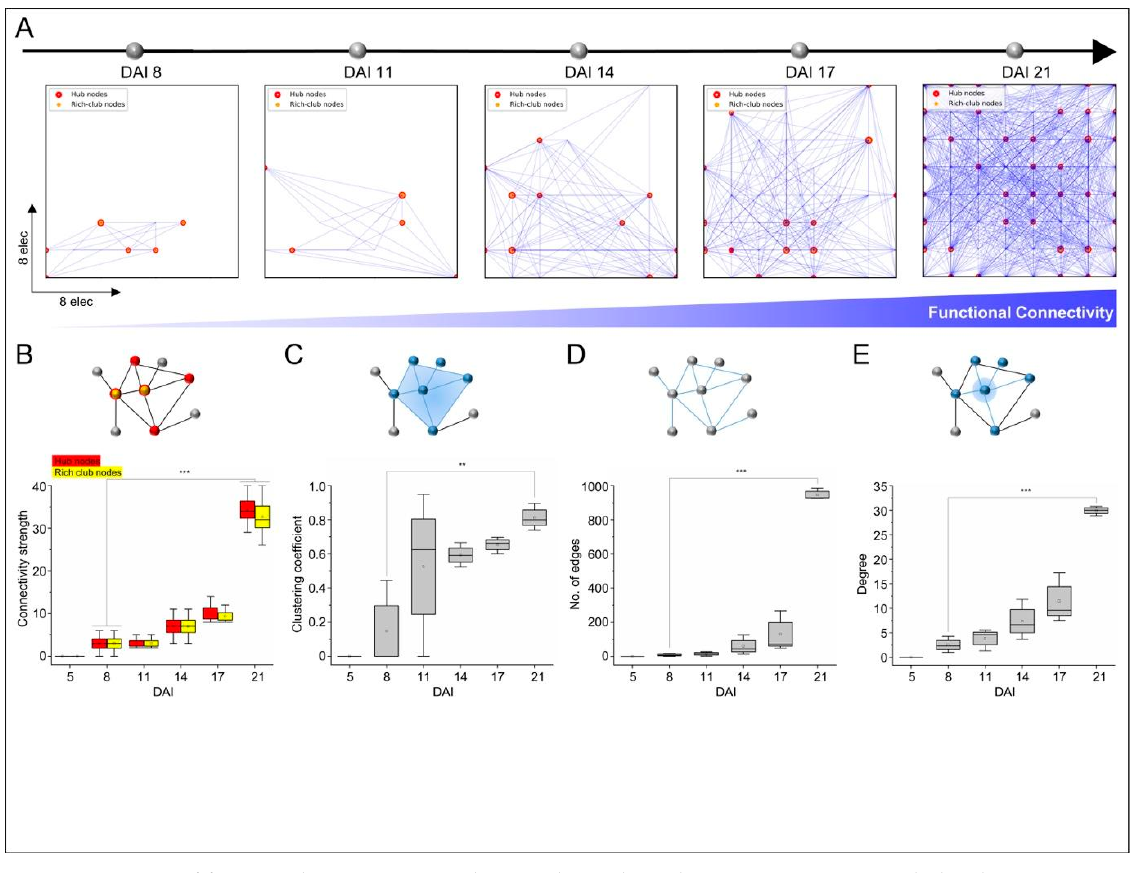
Figure 4. Emergence of functional connectivity and network topology during NPC-iNs network development. ( A ) Maps of functional connectivity during developmental phases showing increased spatial interconnected firing electrodes. ( B ) These maps also display hub nodes that are significantly increasing spatially with development by receiving communication through links from other nodes. Those node connections’ strength is also assessed with rich-club characterization that is significantly increasing during development ( p < 0.001, ANOVA). ( C – E ) All graph topological metrics in matured NPC-iNs networks display significantly higher values than early developed networks ( p < 0.01, 0.001, ANOVA, N = 3).